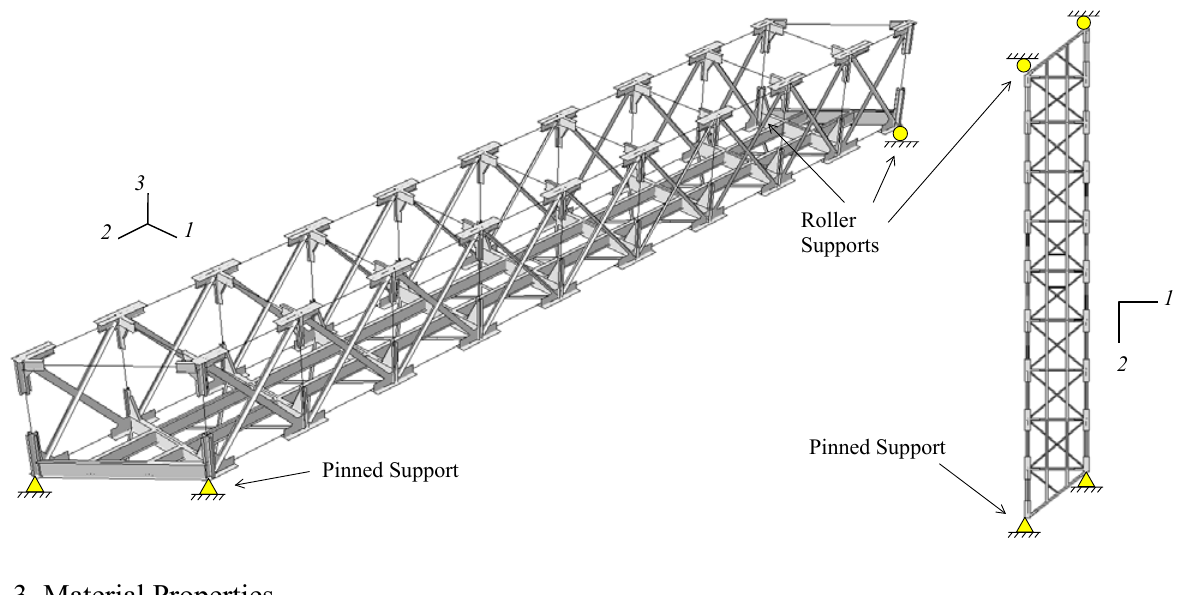
Figure 5. Bridge model support boundary